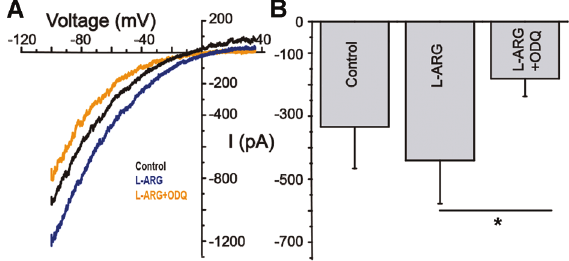
Figure 6. Purinergic modulation is dependent of the soluble guanylate cyclase (sGC). A , I (cid:2) V plot of the ATP-evoked currents in control condition (black), after 10 min of incubation with L-arginine (blue), and after 10 min of treatment with L-arginine + ODQ (orange). The bar graph in B shows the means ± SE amplitude for the currents measured at – 70 mV. We observed a signi fi cant decrease in current amplitudes after sGC inhibition. *P p 0.05, n=6 cells (ANOVA and Tukey post-test).